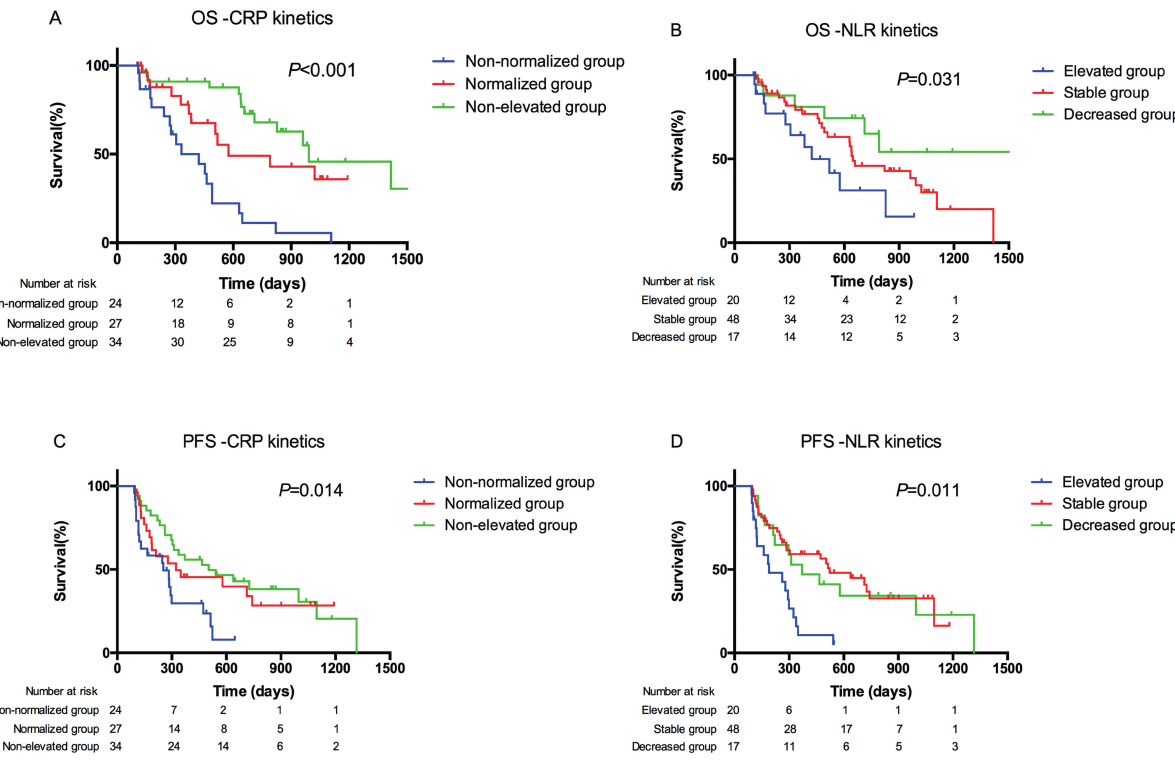
Figure 1 - Overall survival (OS) and progression-free survival (PFS) analysis of patients with metastatic renal cell carcinoma based on cRP and NLR kinetics. Kaplan-Meier analysis of OS for cRP kinetics (A) and NLR kinetics (B), and PFS for cRP kinetics (c) and NLR kinetics